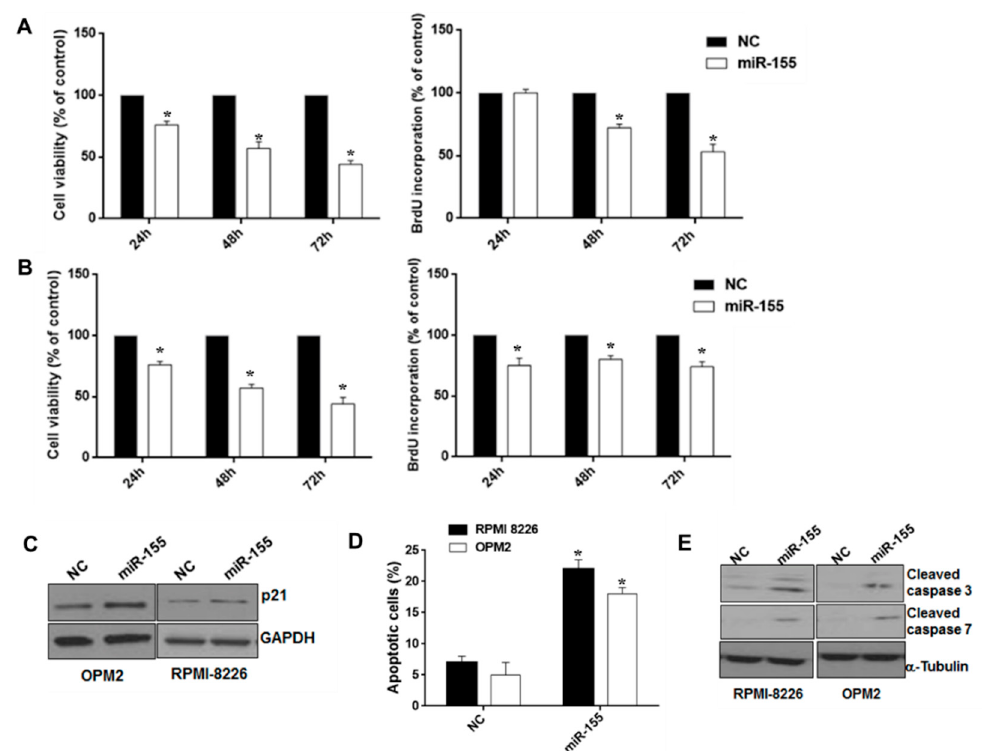
Figure 1. Analysis of miR-155 expression in multiple myeloma primary samples. The miR-155 expression levels in 4 normal donor (N) and 95 primary MM plasma cells (GSE87830); p = 0.01684, as calculated by the Wilcoxon rank sum test. Log2 values of normalized miR-155 expression levels are reported on the y axis.